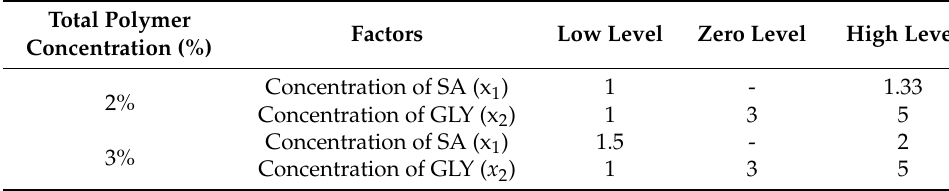
Table 2. The values of factors for mixed two-level and three-level factorial